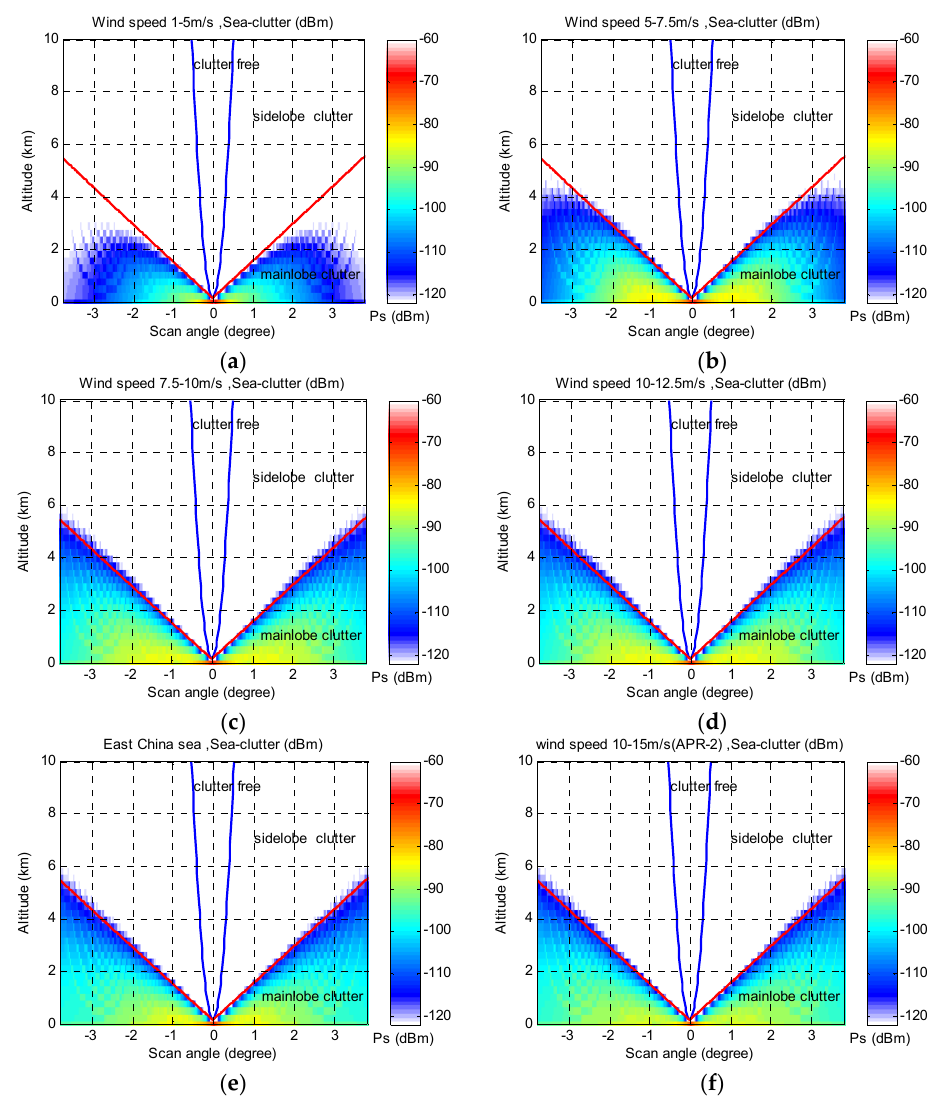
Figure 4. Power distribution (dBm) of sea clutter at different spiral scan angle, without rain attenuation. The figures only show those power values of sea surface clutter greater than the radar receiver’s sensitivity ( − 122 dBm after pulse-average). ( a ) Wind-speed: 1–5 m/s; ( b ) Wind-speed: 5–7.5 m/s; ( c ) Wind-speed: 7.5–10 m/s; ( d ) Wind-speed: 10–12.5 m/s; ( e ) East China sea, NRCS data from TRMM PR; and ( f ) wind-speed: 10–15 m/s, NRCS data from APR-2. The surface clutter powers are proportional to the normalized radar cross-section of sea surface in different scan angles.